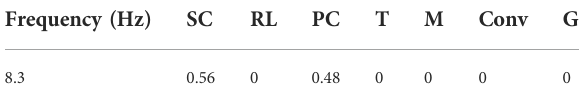
TABLE 3 The MCOM of oscillation mode.